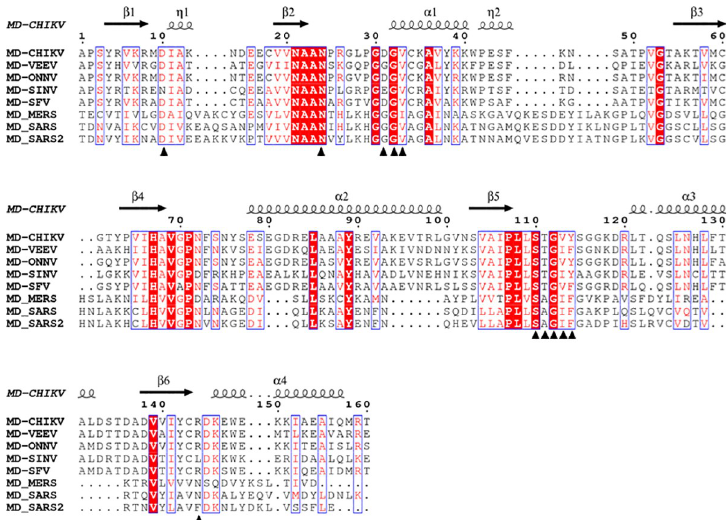
Fig 2. Sequence alignment of alphavirus and coronavirus nsP3 macrodomains (MD). Residue numbers above the sequence correspond to CHIKV nsP3 macrodomain (UniProtKB: Q5XXP4). The secondary structure from the co- crystal structure of nsP3MD with ADP-ribose is shown on the top of the alignment. Residues interacting with ADP- ribose are highlighted in black triangles. Other protein sequences shown here include macrodomains from VEEV (UniProtKB: P36328), ONNV (UniProtKB: P13886), SINV (UniProtKB: P03317), SFV (UniProtKB: P08411), SARS-CoV (PDB ID: 2FAV), MERS-CoV (PDB ID: 5HOL) and SARS-CoV-2 (SARS2) (PDB ID: 6W02). This figure was generated by using ESPript 3.0 [50].